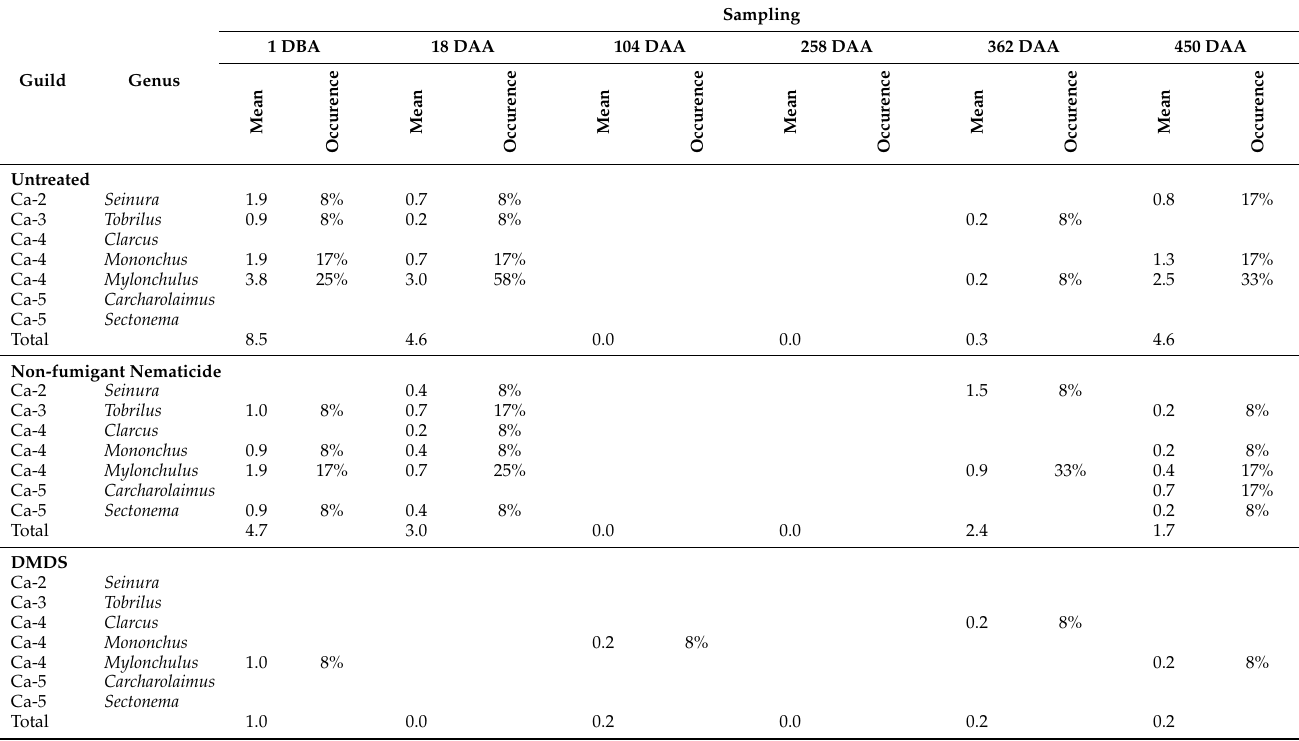
Table A5. Animal predator nematodes structure. Abundance and occurrence in trial variants during study period.